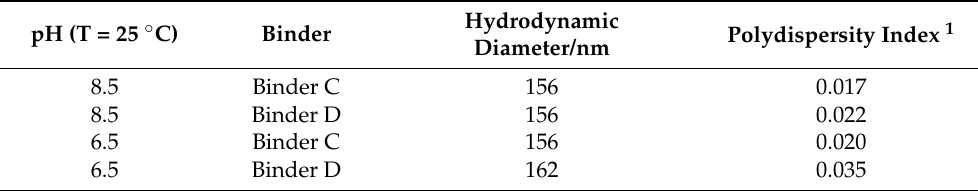
Table 1. Light scattering results for the new binder D and binder C without the tertiary polyamine.